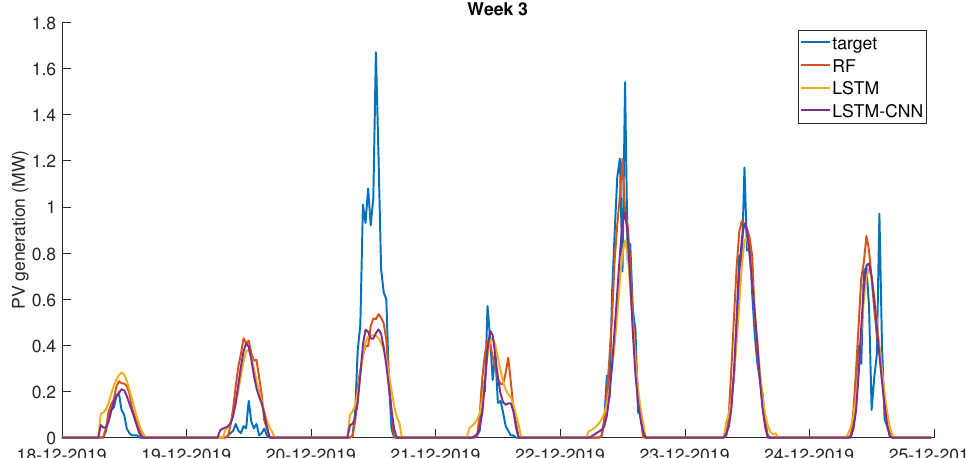
Figure 6. Plots of model predictions for week 3. The prediction of PV power output is more challenging at low